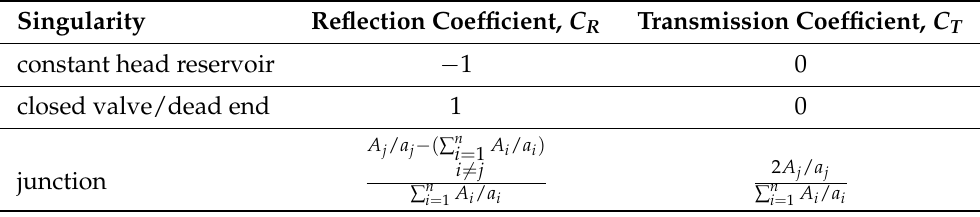
Table 2. The reflection and transmission coefficients given by the Lagrangian model (LM) for the singularities of the